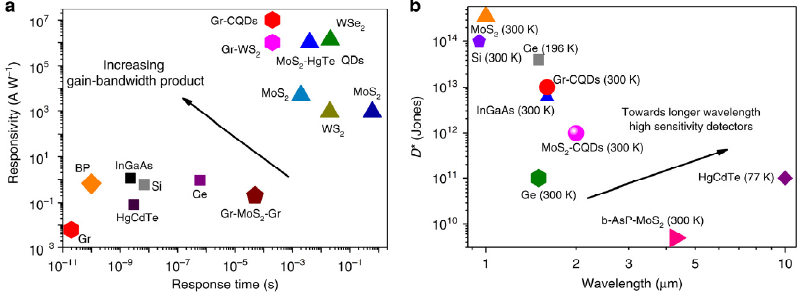
Figure 8. Responsivity ( a ) and detectivity ( b ) of 2D photodetector technologies and technologies currently in use [26]. currently in use [26].